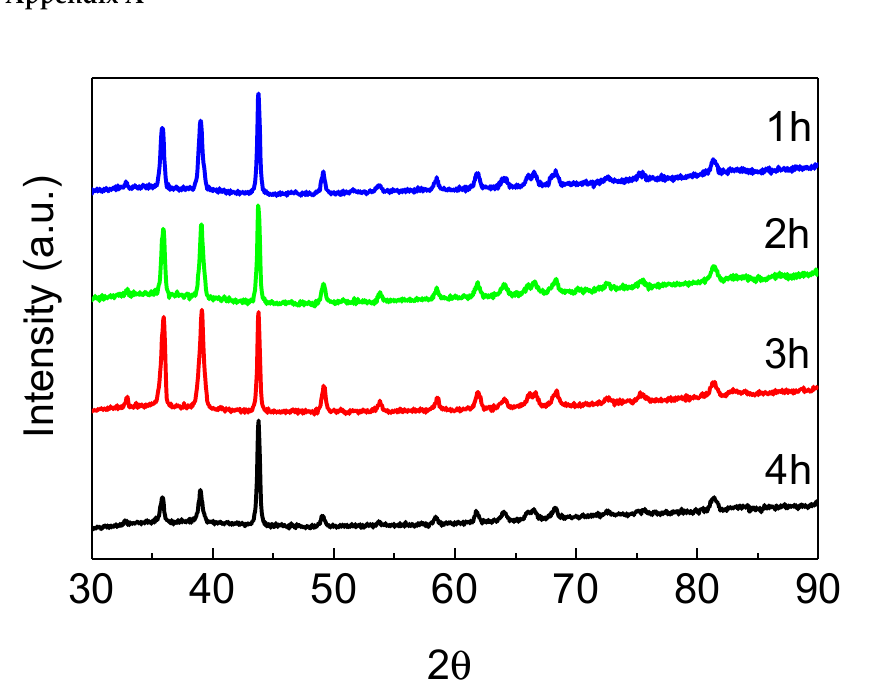
Figure A1. XRD patterns of crushed hollow fibers calcined at 600 °C for different times (1, 2, 3 and 4 h, respectively). The diffraction lines indicate the fibers are composed of CuO after calcination.